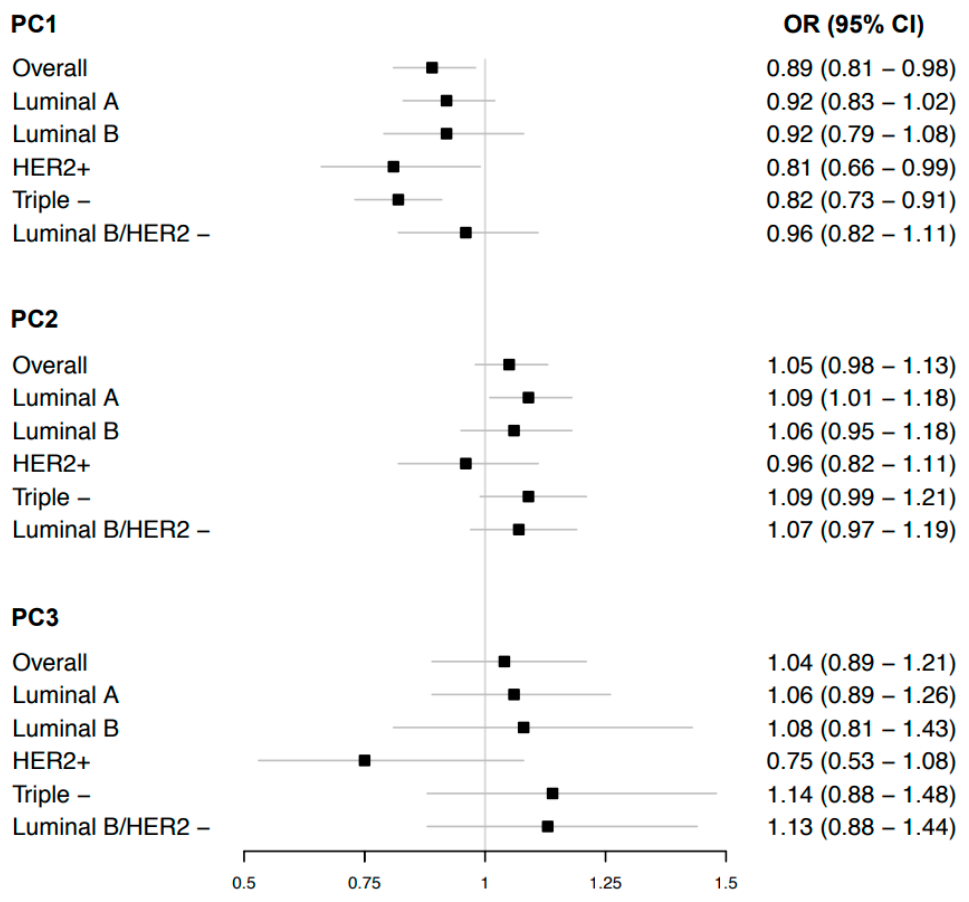
Figure 2. Mendelian randomization estimates between body shape phenotype PC1, PC2, and PC3 and overall breast cancer risk and sub-types. CI, confidence interval; OR, odds ratio; PC, principal component. We report random-effect IVW results due to heterogeneity across the genetic instru- ments.